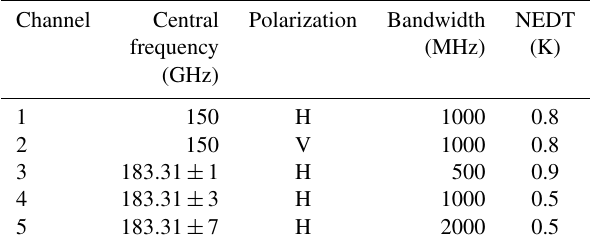
Table 1. Channel characteristics of the MWHS. Note: NEDT is noise equivalent delta